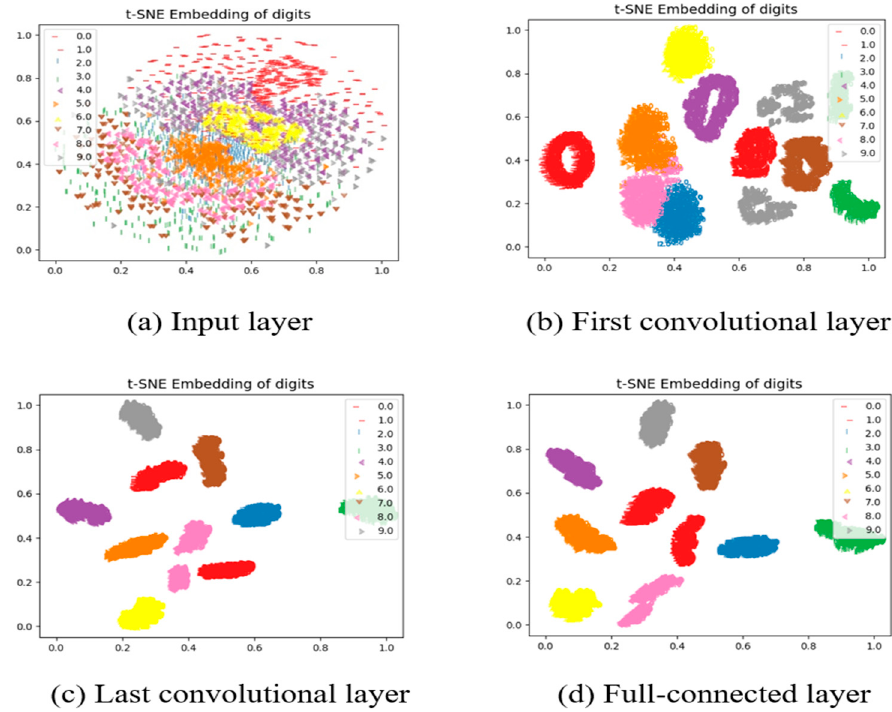
Figure 21. Results of t-SNE visualization analysis.